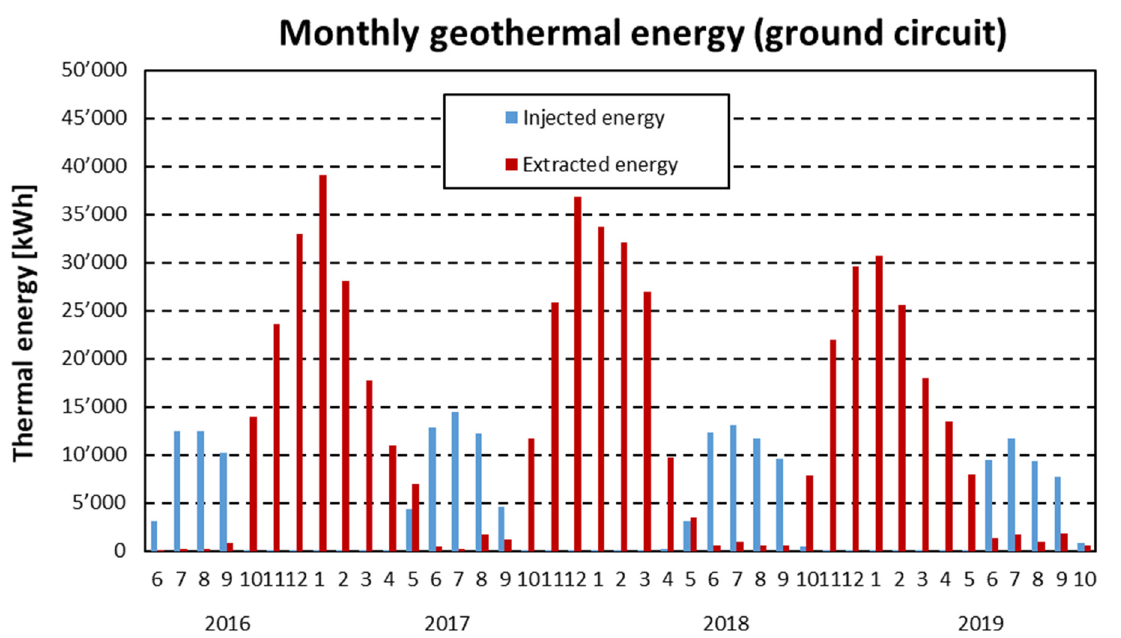
Figure 7. Monthly energy exchanged with the ground (at the heat meter “Q1”) during the monitoring (years and months in the abscissa labels; source: [22]).